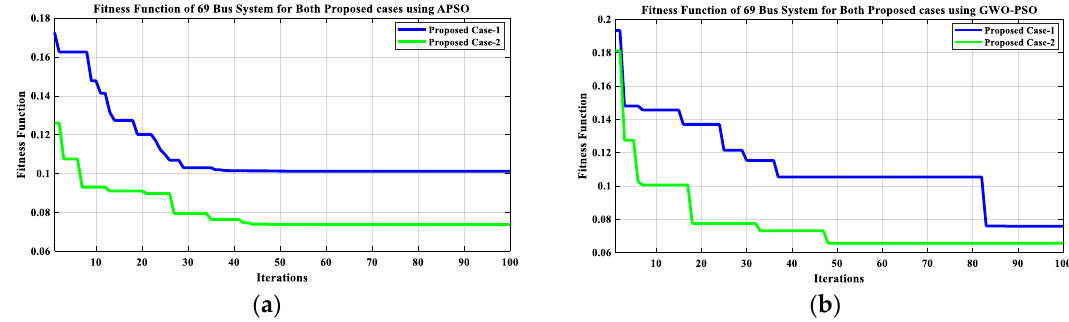
Figure 27. Proposed cases 𝑀𝑂 𝐹𝐹 of the 69-bus RDN; ( a ) APSO, ( b ) GWO-PSO.